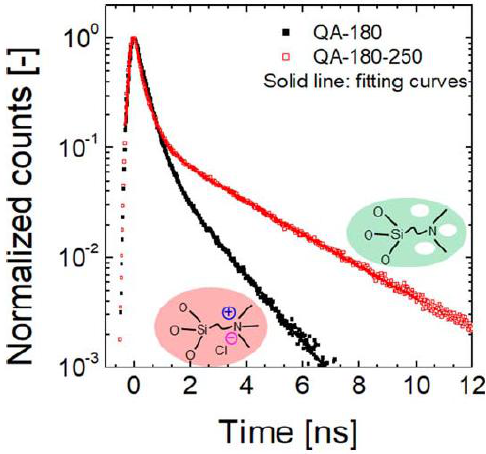
Figure 7. PALS data for quaternary ammonium-silica films fabricated on silica wafers, as recorded